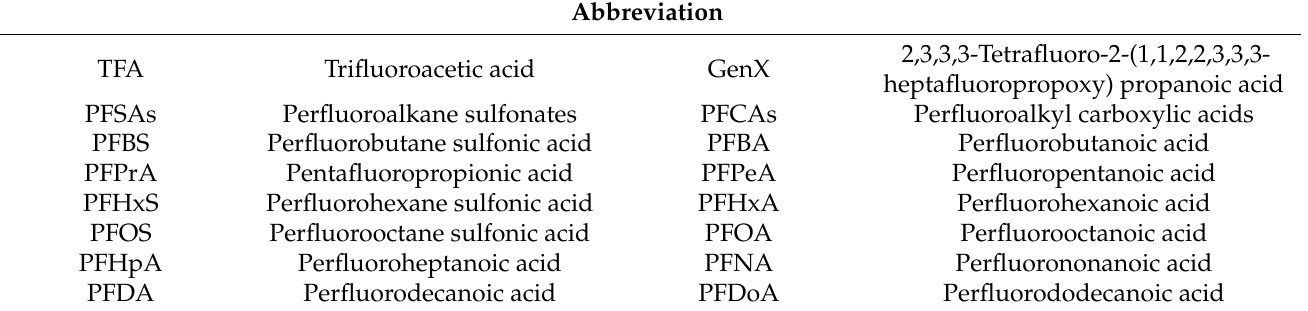
Table 1. Abbreviation for different